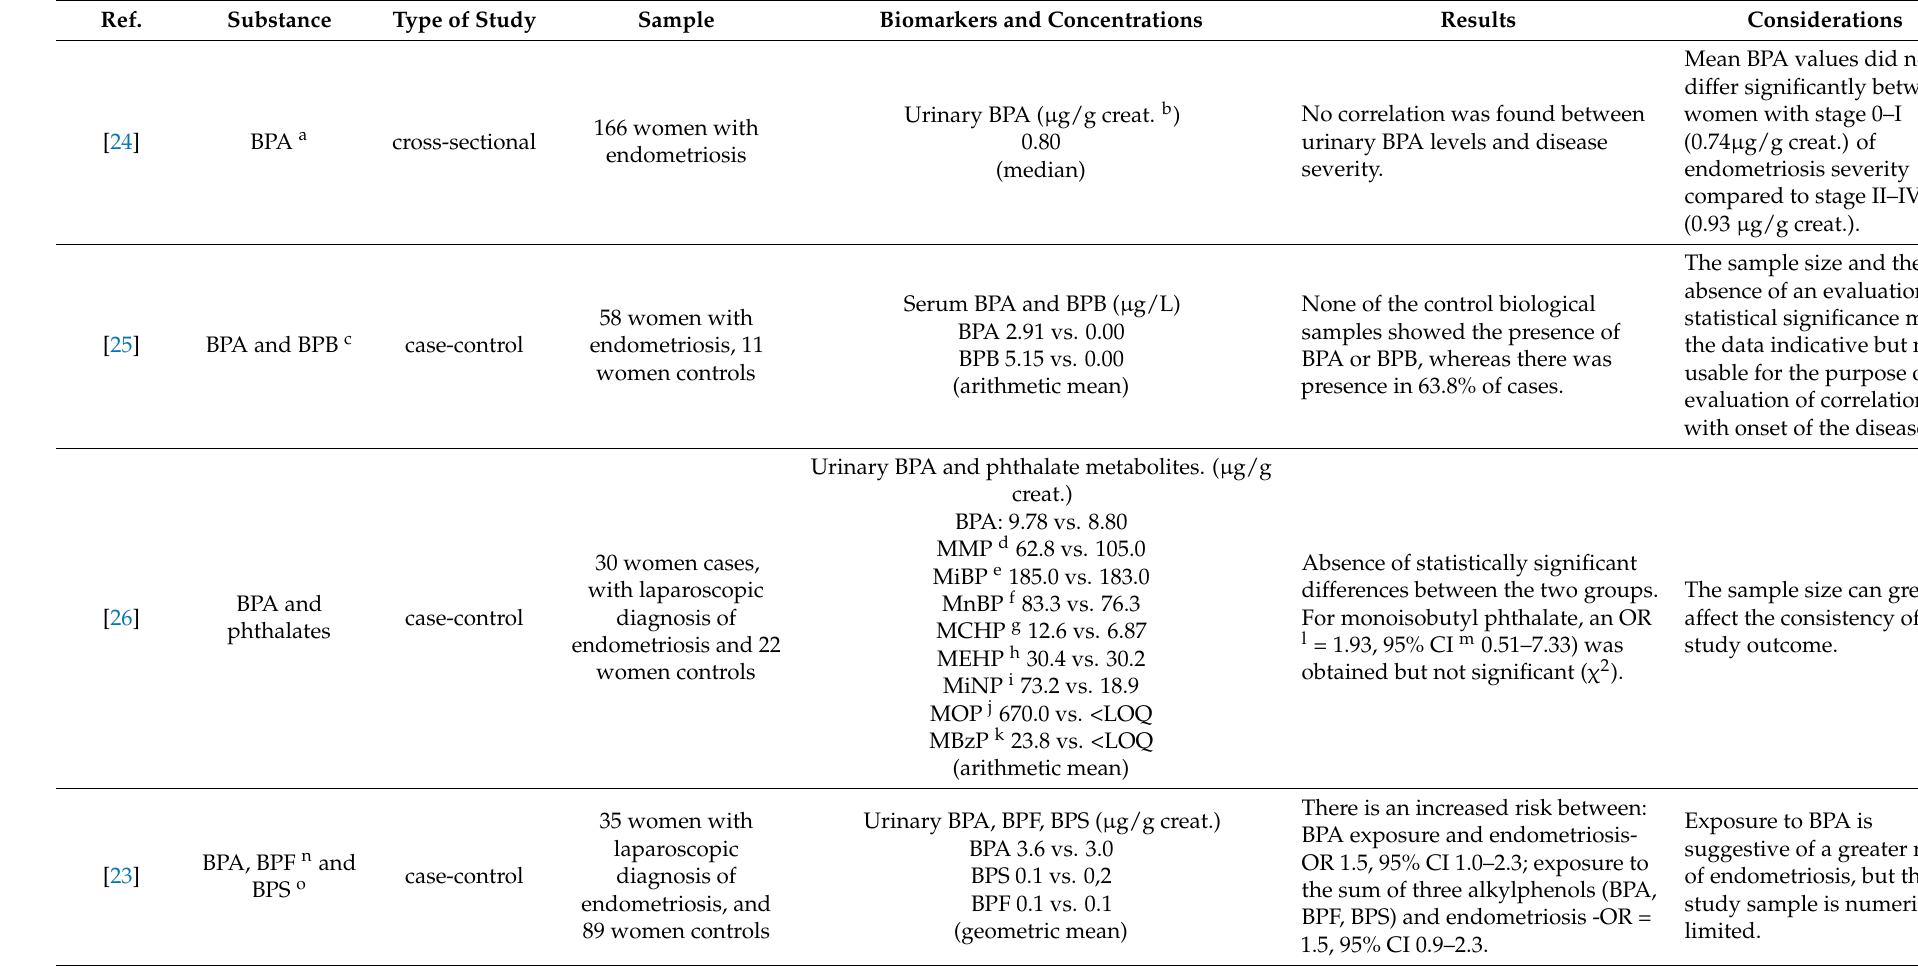
Table 1. Description of the investigations conducted with respect to phthalates and/or bisphenols exposure and endometriosis.